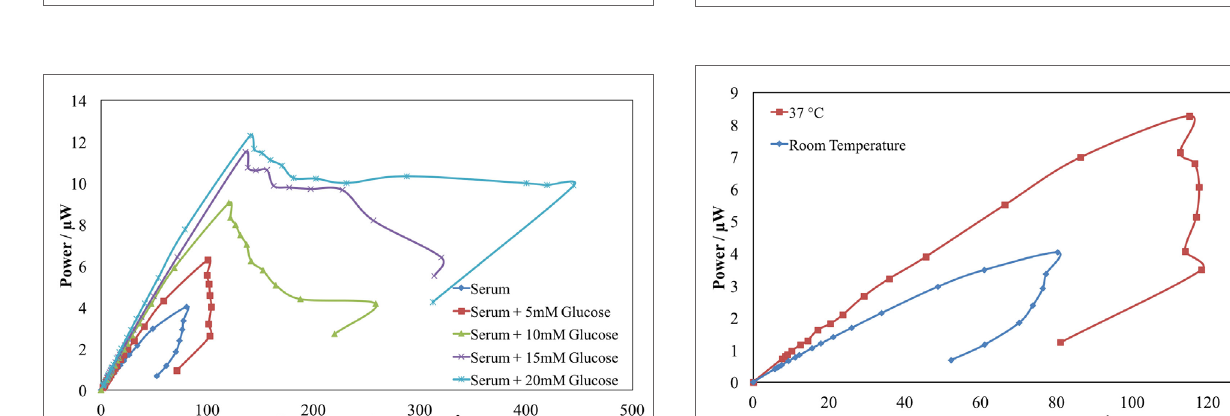
FigUre 6 | Maximum produced power by the biofuel cell as a function of the glucose concentration at external load of 10 k Ω .